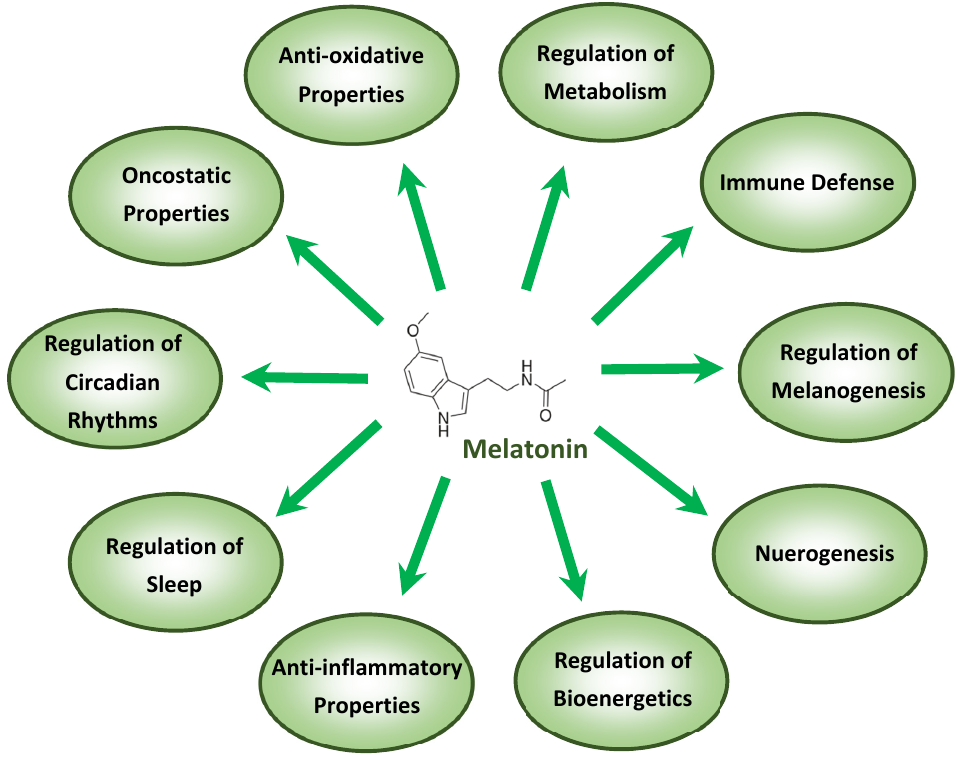
Figure 2. The most important functions of melatonin, some of which apply to the treatment of viral diseases including COVID-19.